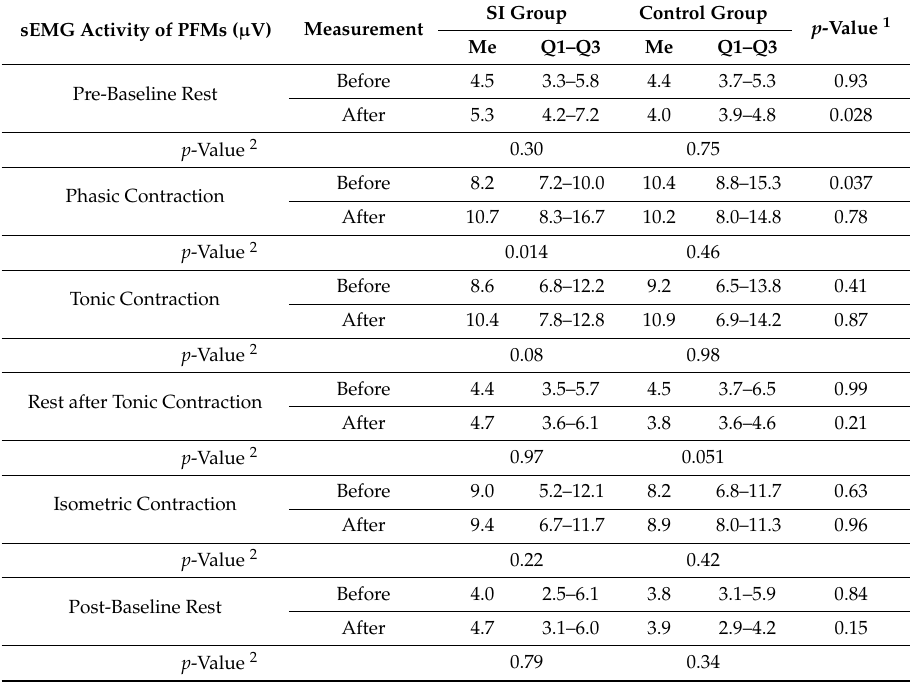
Table 5. Comparison of the sEMG amplitude of PFM ( µ V) before and after the intervention in the experimental (SI) and control groups in standing